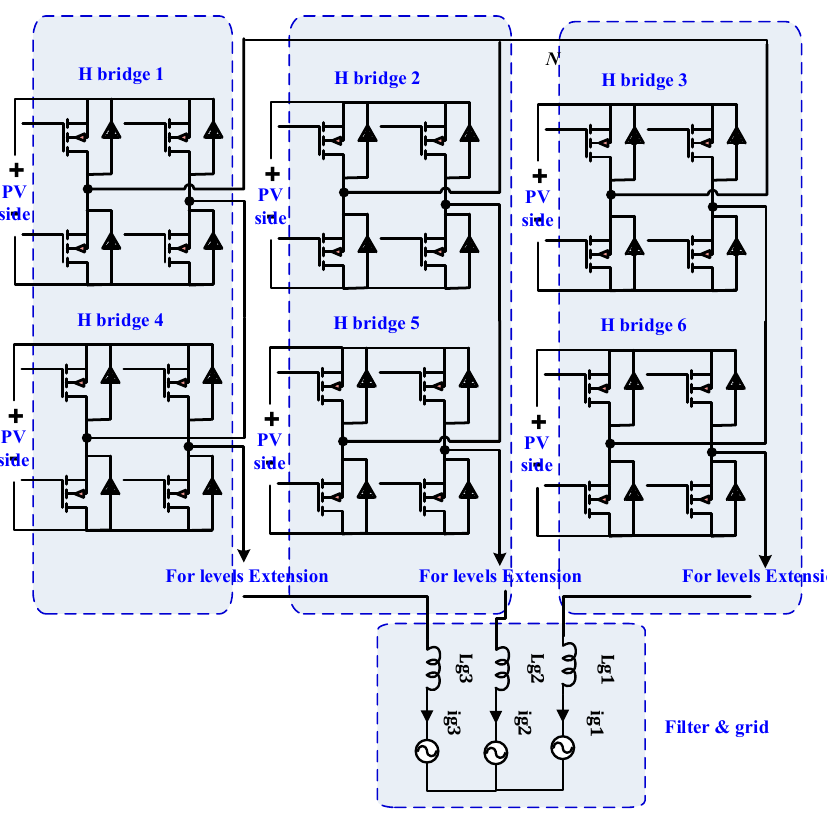
Figure 22. Cascaded H-bridge three-phase multi-input inverters [61,112].